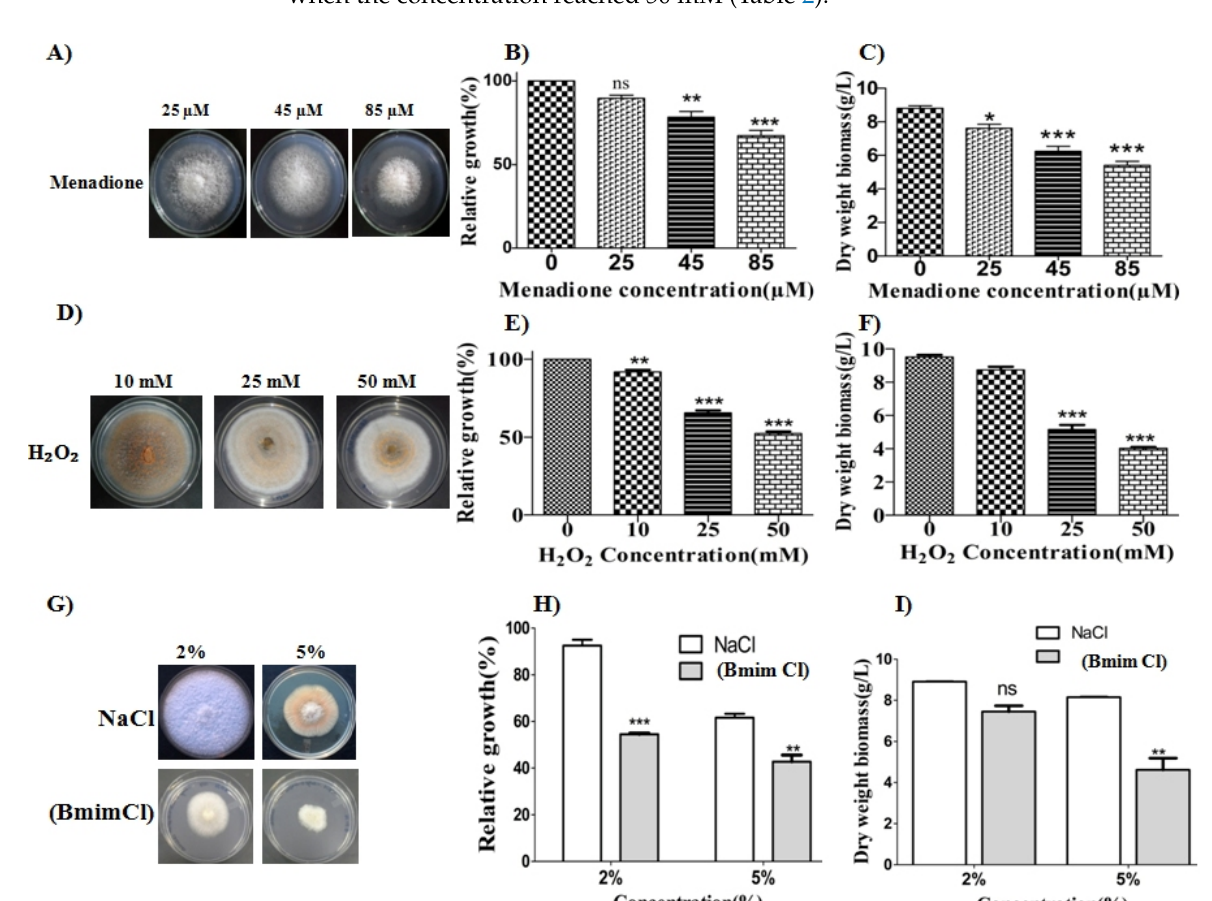
Figure 4. Effect of lignocellulosic pretreatment compounds on Colletotrichum sp. OH growth. Oxidative stress response of OH to menadione and H 2 O 2 . ( A , D ) The mycelial growth in the presence of menadione and H ₂ O ₂ ; ( B , C , E , F ) the relative mycelial growth (%) and dry weight biomass (g/L) of OH on the seventh day; and ( G – I ) the relative growth (%) and dry weight biomass (g/L) in the presence of ionic liquid 1-butyl-3-methylimidazolium chloride (Bmim Cl). Statistical differences were analyzed by one-way analysis of variance (ANOVA). Experiments were performed in triplicate, and the heights of the bars and the error bars indicate the means ± standard error mean (SEM). *** p < 0.001; ** p < 0.01; * p < 0.05 compared with the control.